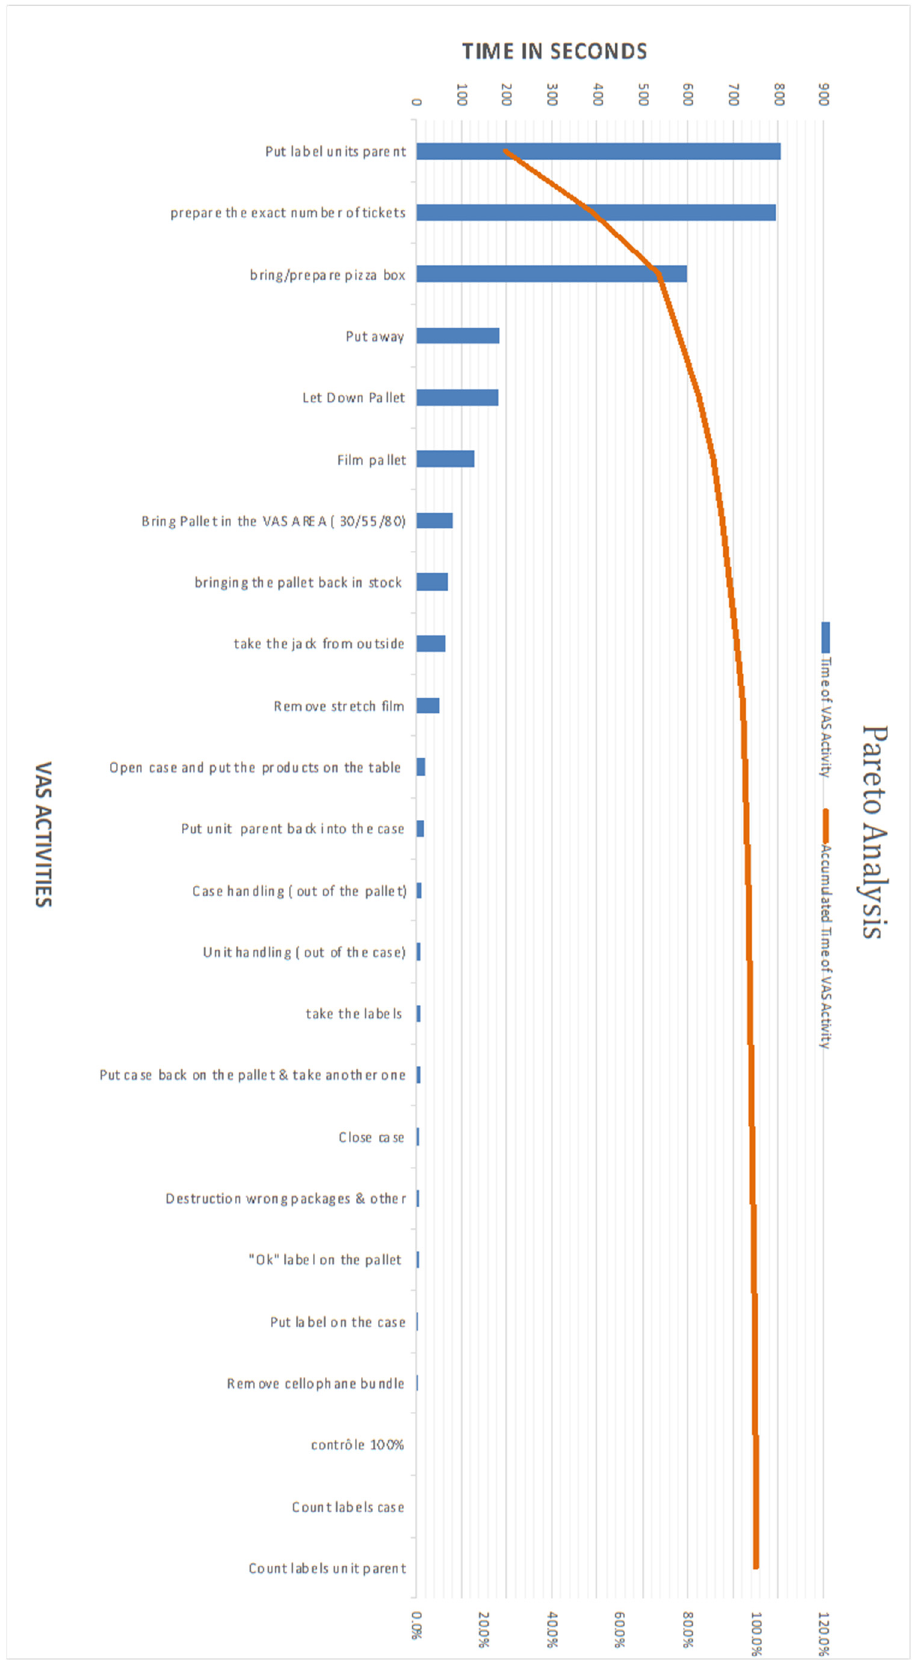
Figure 3. Pareto analysis for narcotic analgesics—ticketing.